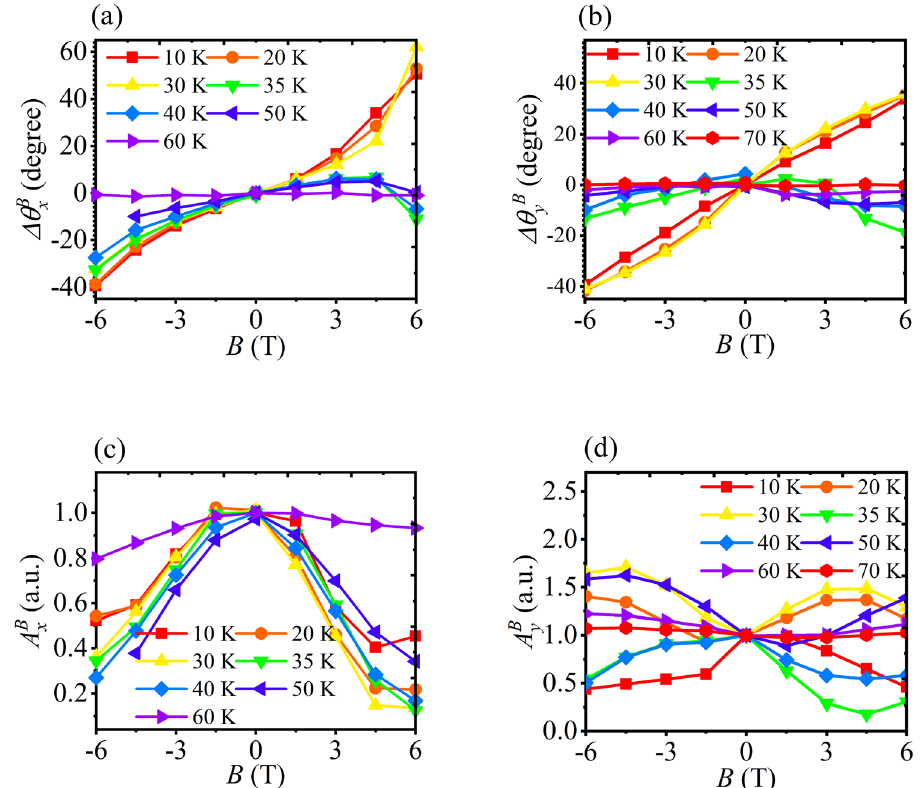
Fig. 2 Magnetic fi eld-dependent bulk photovoltaic (BPV) characteristics at various temperatures (10 K to 70 K). a Magnetic fi eld-dependent angle shifts of BPV current along x direction 4 θ B x . b Magnetic fi eld-dependent angle shifts of BPV current along the y dire c tion 4 θ B y . c Magnetic fi eld-dependent amplitude of BPV current along x direction A B x . d Magnetic fi eld-dependent amplitudes of BPV current along the y direction A B y . The directions x and y are de fi ned in Fig. 1a. The error bars in the plots represent the standard error. The error bars are obtained from the standard deviation of the least-squares fi t parameters and are smaller than the